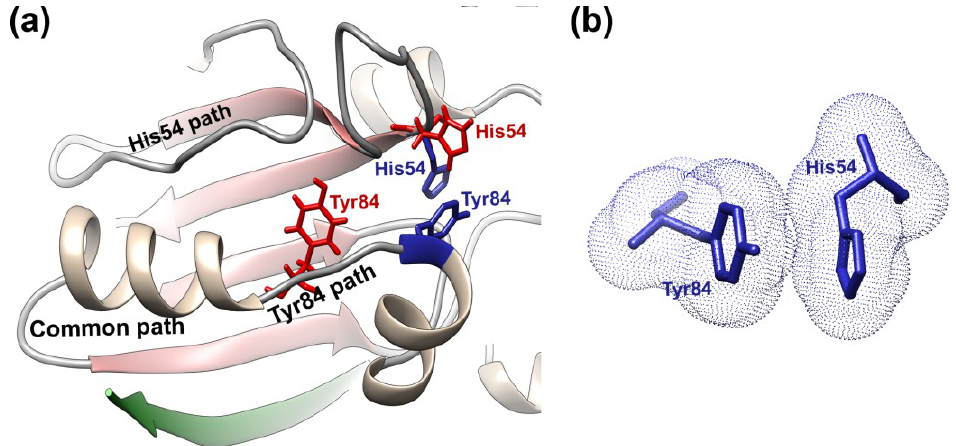
Figure 4. AVP activation pathway and cation-π interaction. ( a ) Upon binding of pVIc (green) to AVP, a series of contiguous conformational changes occur along a common path that bifurcates into an upper and lower path. At the end of the upper path, His54 drops down from its position in AVP (red) to a position in AVP-pVIc (blue) that is opposite Cys122. At the end of the lower path, Tyr84 (red) moves 11 Å to a position in AVP-pVIc (blue) where it can form a cation-π interaction with His54; ( b ) Electron clouds of Tyr84 and His54 in their cation-π interaction. Figure created with UCSF Chimera